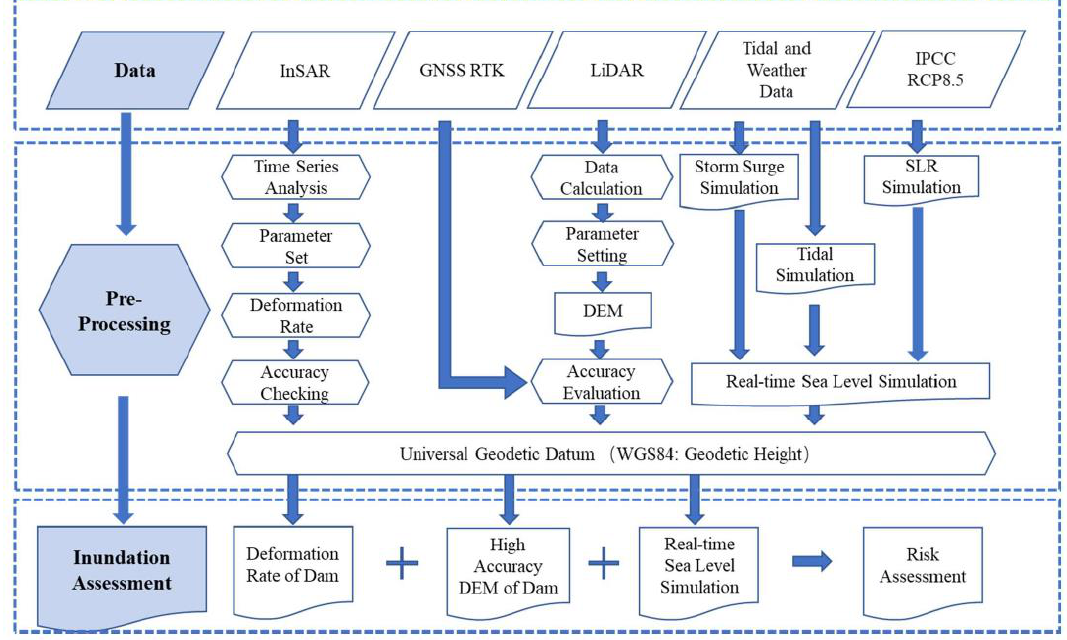
Figure 4. Flow chart of inundation assessment in this study.